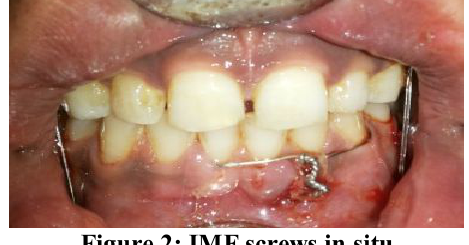
Figure 2: IMF screws in situ.